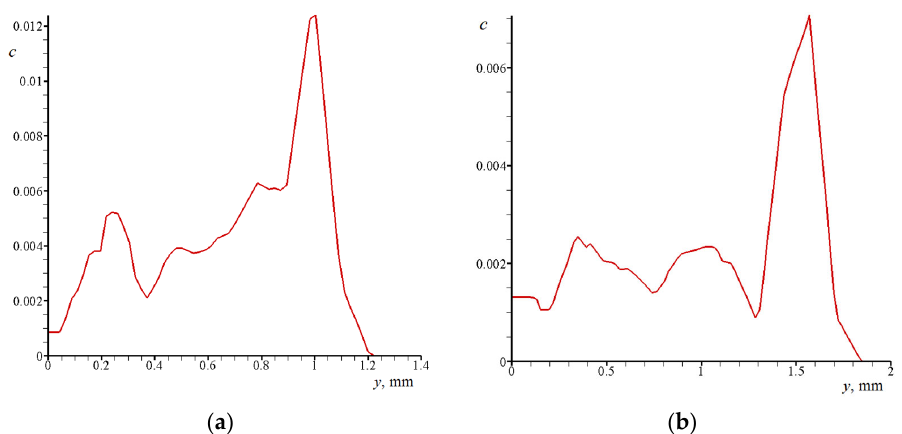
Figure 9. The distribution of particle concentration across the flow in two cross-sections: ( a )— x = 23 mm; ( b )— x = 30 mm. In order to exclude the influence due to the friction force acting from the side of the disks on the two-phase flow, we performed calculations for a large inter-disk spacing, h = 0.4 mm, at the rate of particle consumption being j s = 1.168 · 10 − 3 kg/s. The calculated data for Mach-number isolines are shown in Figure 10.